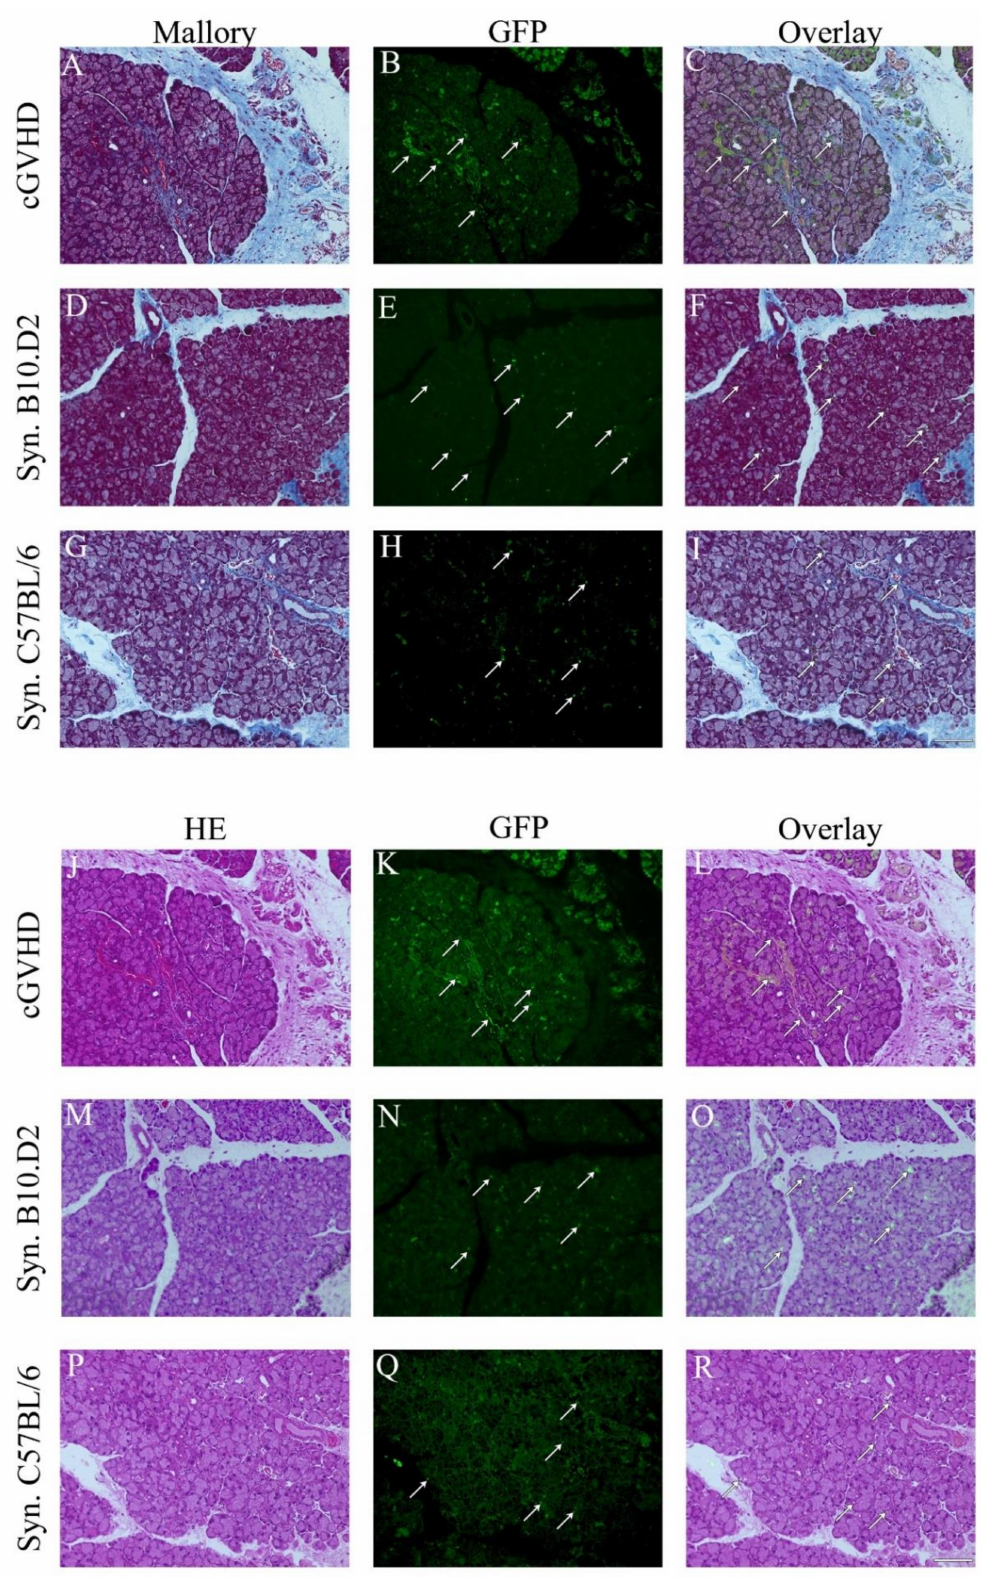
Figure 2. Mesenchymal stem cells become different phenotype after syngeneic and allogeneic MSC transplantation. Mallory (top A – I ) and HE (bottom J – R ) staining of the lacrimal gland in the allogeneic (cGVHD n = 19) and two syngeneic models (B10.D2 ( n = 3) and C57BL/6 ( n = 25) recipient mice). Scale bar = 100 µ m, 200 × magnification. Arrows indicate GFP + cells. Mallory and HE staining are on the left side. The middle depicts the GFP channel and the right is a merge of